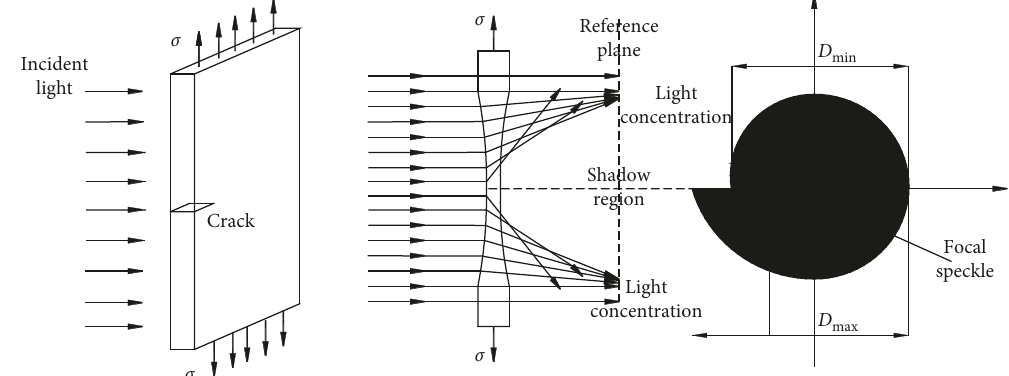
Figure 1: Schematic diagram of caustics formation.